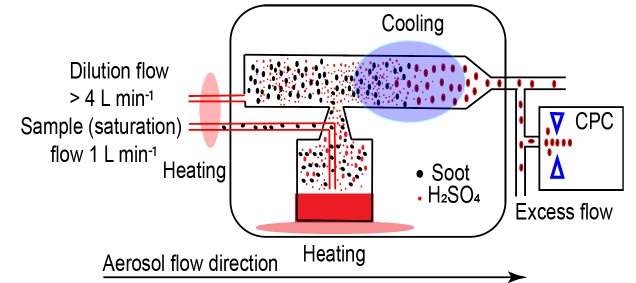
Figure 2. The schematic of the coating apparatus. Red line denotes heated tubing. Light red-shaded area denotes the heating block. Purple-shaded area denotes the water cooling